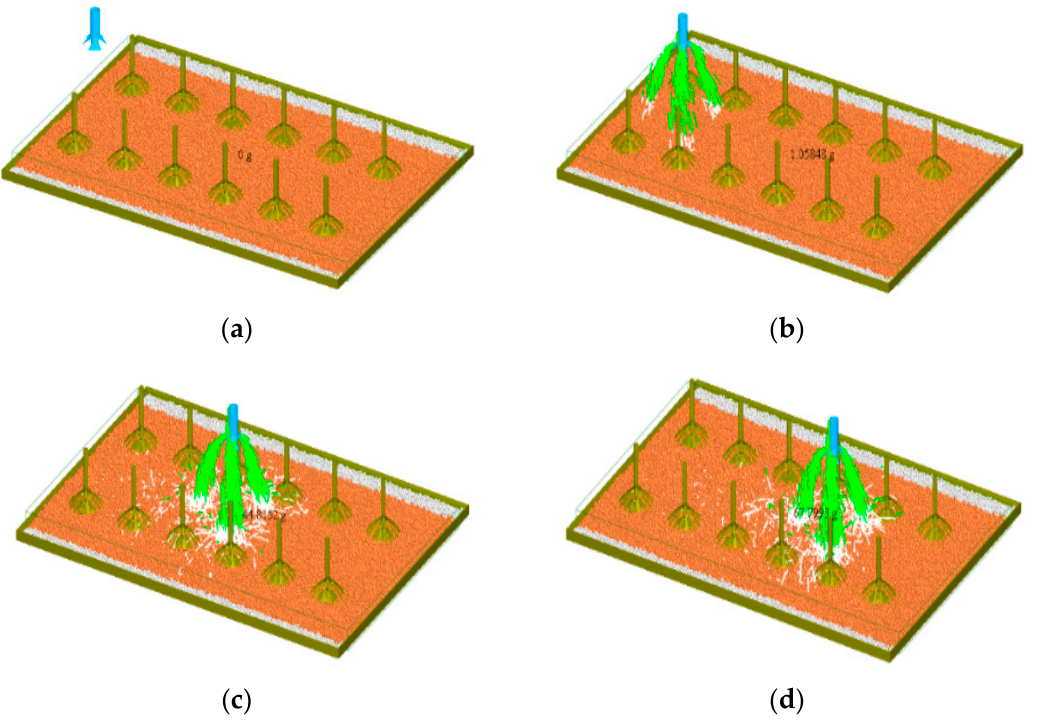
Figure 7. Fertilizer spreading process in simulation test. ( a ) 0.72 s, ( b ) 1.22 s, ( c ) 1.94 s, ( d ) 2.83 s.